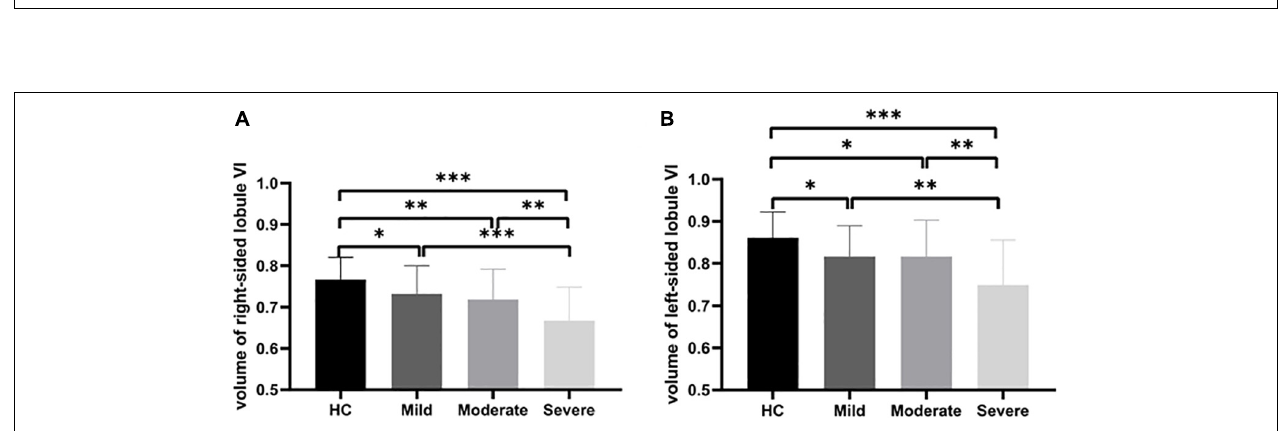
FIGURE 1 | Voxel-based morphometry showing gray matter loss in the cerebellar subregions for patients with White matter hyperintensities (WMHs) in comparison with controls. Areas of significant gray matter loss (red) included the cerebellar subregions right-sided lobule VI [voxel size: 2,106; peak MNI coordinates: x = 22.5, y = –63, and z = –15; Gaussian random field (GRF) for voxel levels at P < 0.001 and cluster at P < 0.05] and left-sided lobule VI (voxel size: 703; peak MNI coordinates: x = –22.5, y = –54, and z = –15; GRF for voxel levels at P < 0.001 and cluster at P < 0.05), for patients with WMHs vs. control subjects.